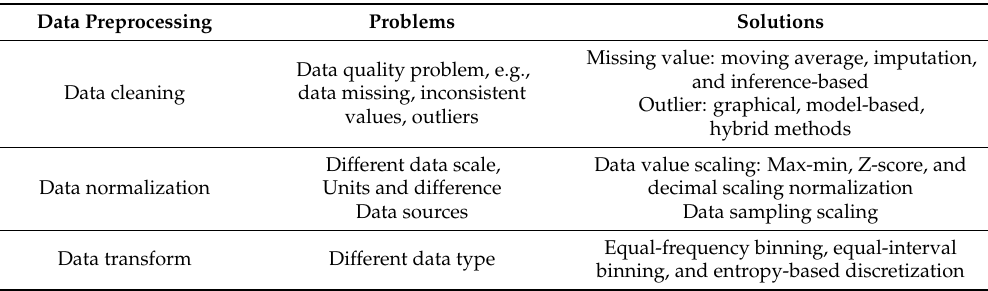
Table 1. The problems and solutions for data preprocessing.